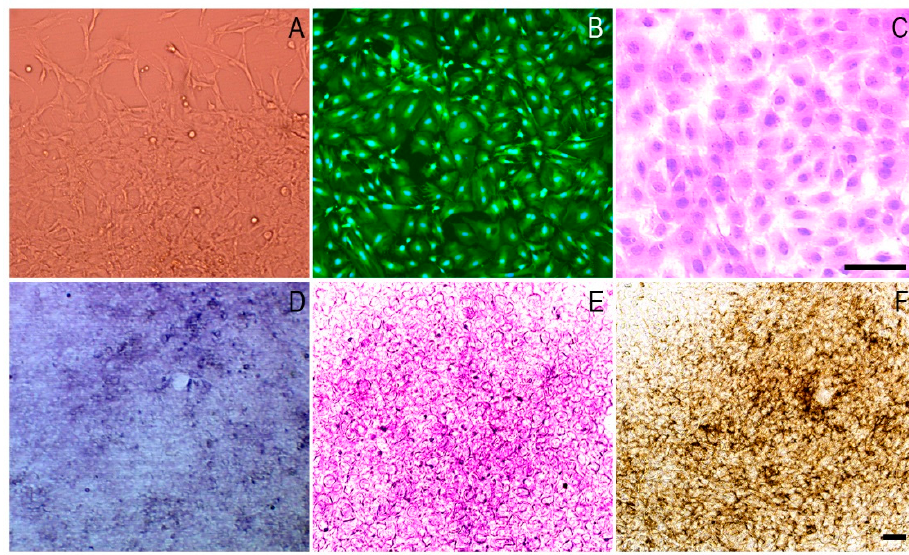
Figure 5. Phase contrast microscopy images of the morphology and differentiation of MC3T3-E1 cells.